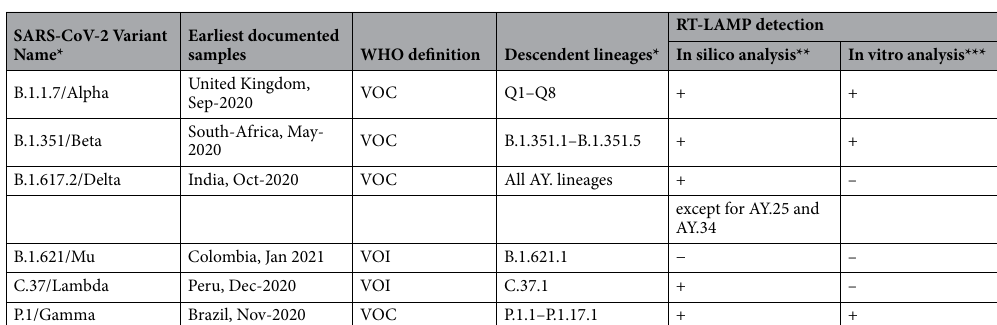
Table 4. Variant detection analysis using salivary RT-LAMP assay. *Lineages and their descendents were from cov-lineages.org, updated on November 10, 2021. **In silico analysis considered as positive, variants presenting a perfect matched alignment with RT-LAMP primers with a frequency of at least 95% of all sequencing deposed on GISAID during the period of analysis (updated on November 02, 2021). ***RT-LAMP In vitro analysis were performed as described in Method section using referenced commercial samples from Twist Bioscience (B.1.1.7 – ref# 103,926; B.1.351 – ref# 104,043; P.1 – ref# 104,044). ( +) Positive detection; (−) Negative detection; (–) Not determined; VOC, variants of concern; VOI, variants of